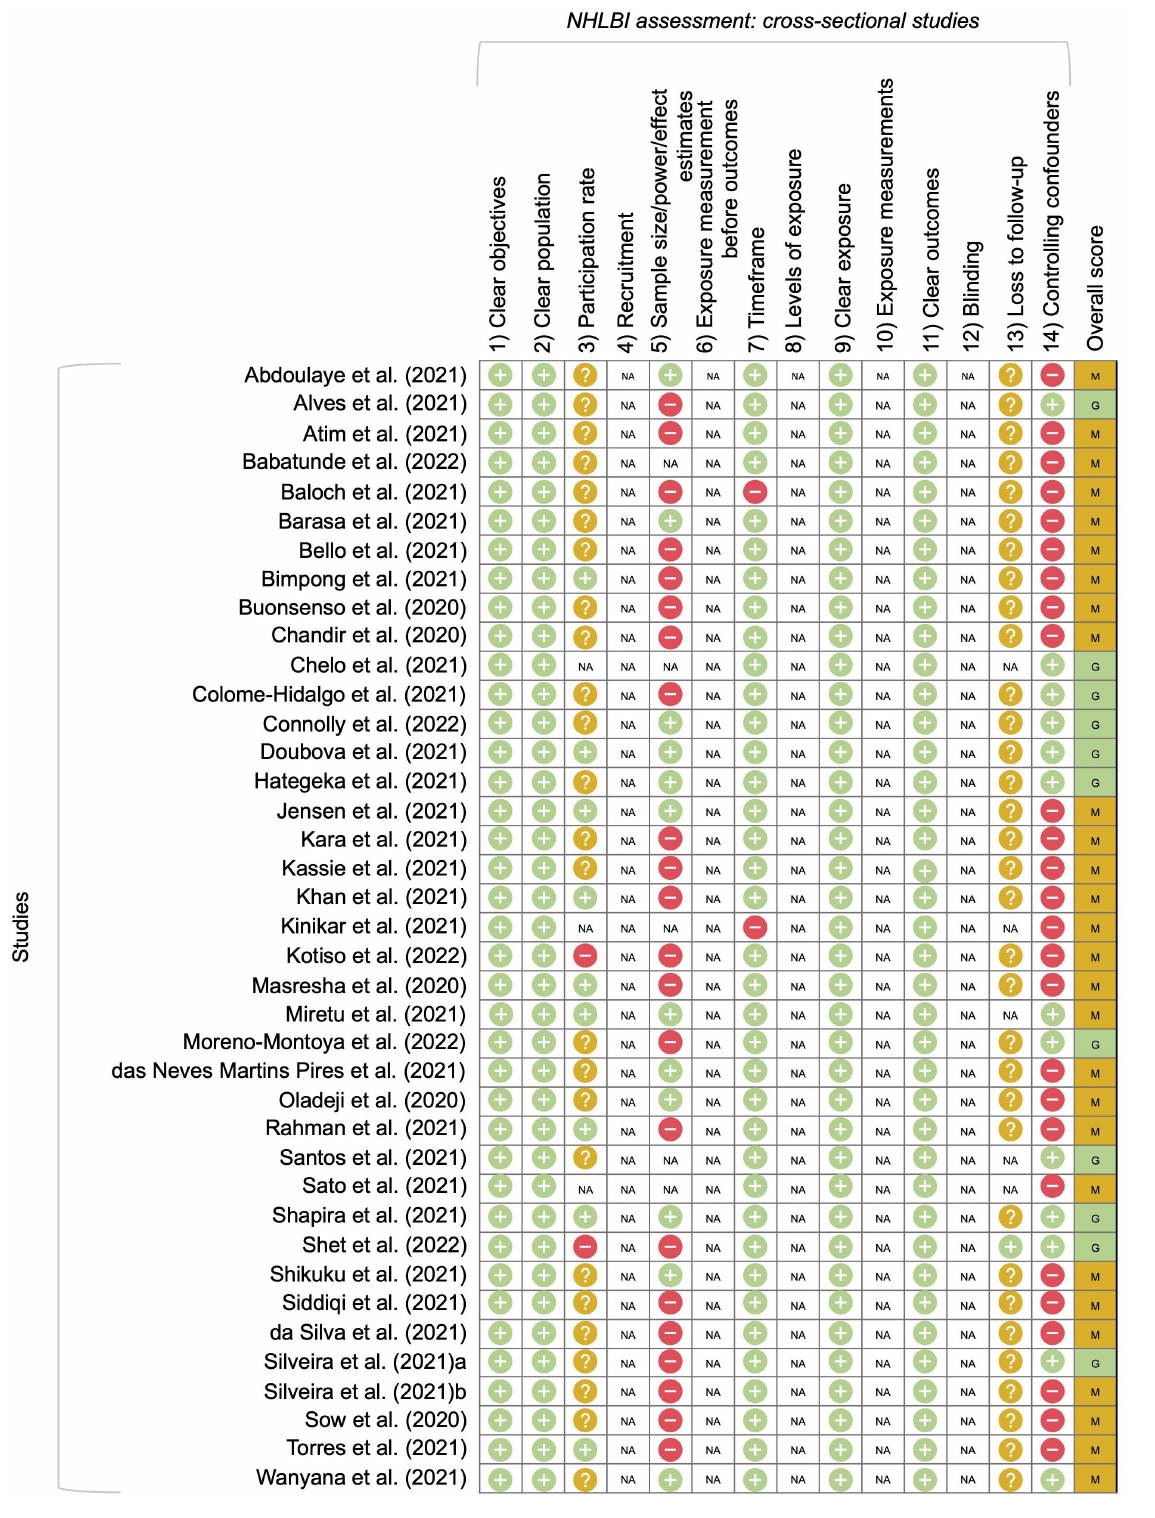
FIGURE2 NHLBI assessments for included studies [Overall scores: good (G), moderate (M), poor